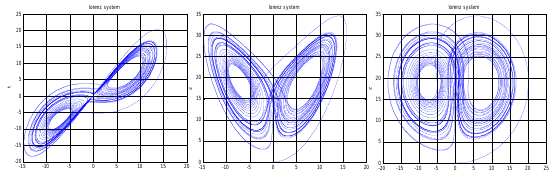
Figure 1. Chaotic behavior of the state variables of the Lorenz system.